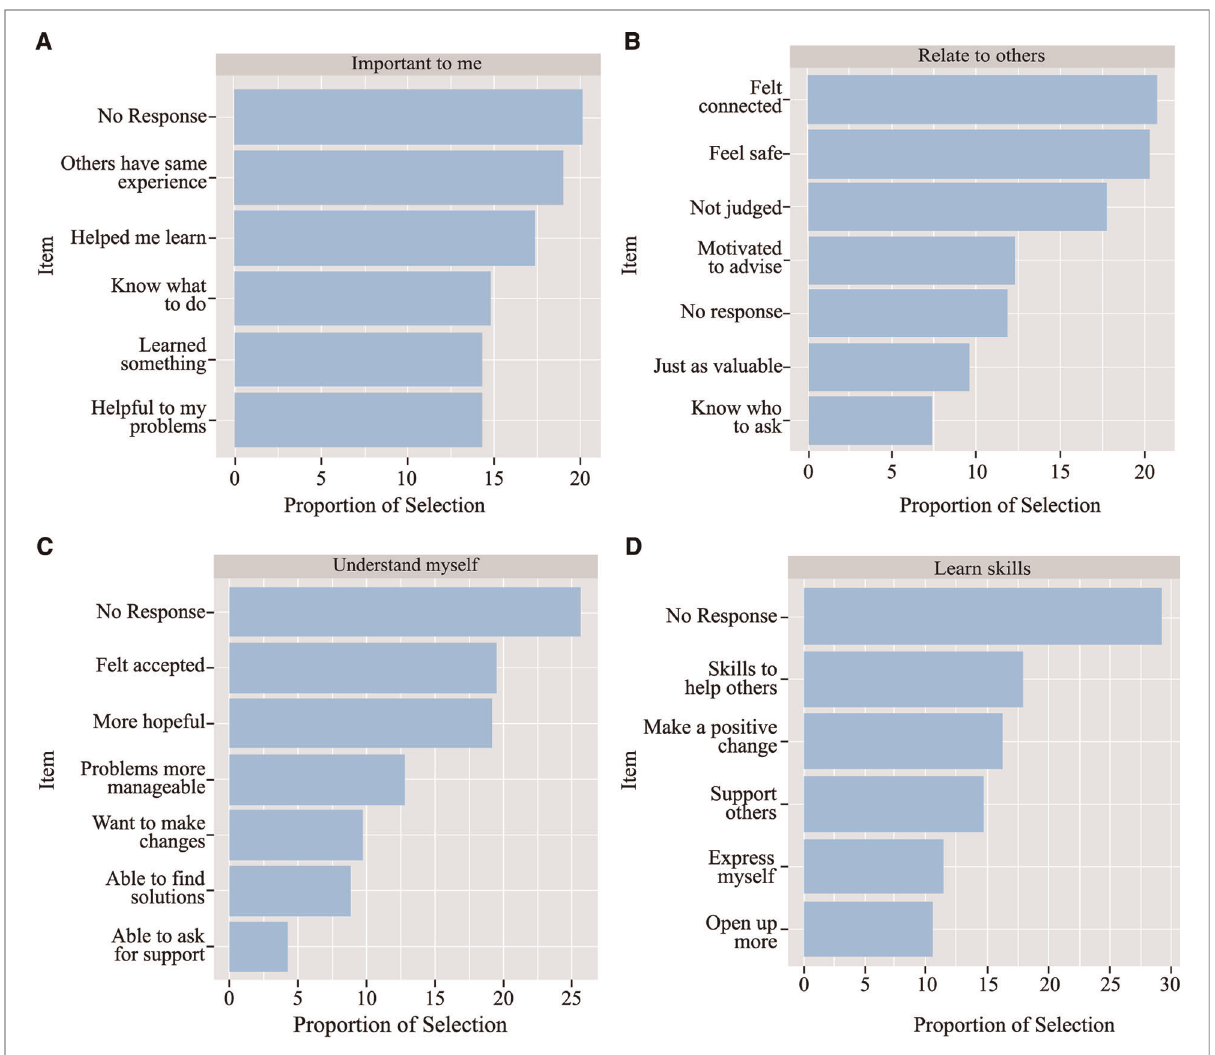
FIGURE 7 POCEM selection frequency of outcomes for each domain. Each panel shows the proportion of selection for outcomes selected by High-level domain of support selection: ( A ) “ Important to me ” ; ( B ) “ Relate to others ” ; ( C ) “ Understand myself ” ; ( D ) “ Learn skills ”